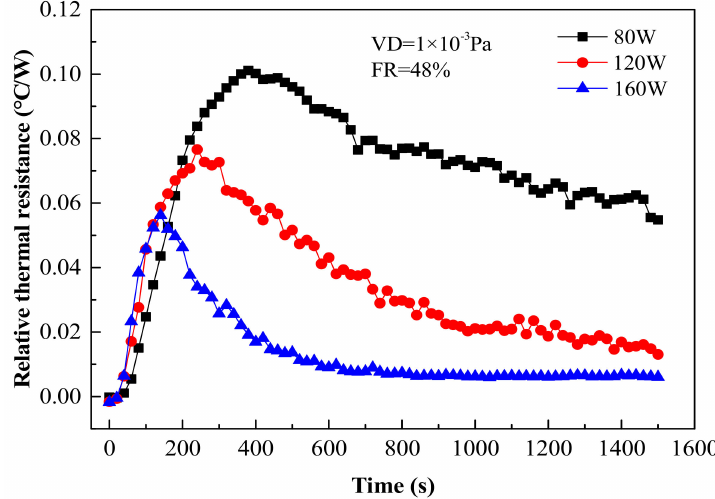
Figure 12. The relative thermal resistance on the Z-axis of the PGHP changing with heating time under different heating power inputs.